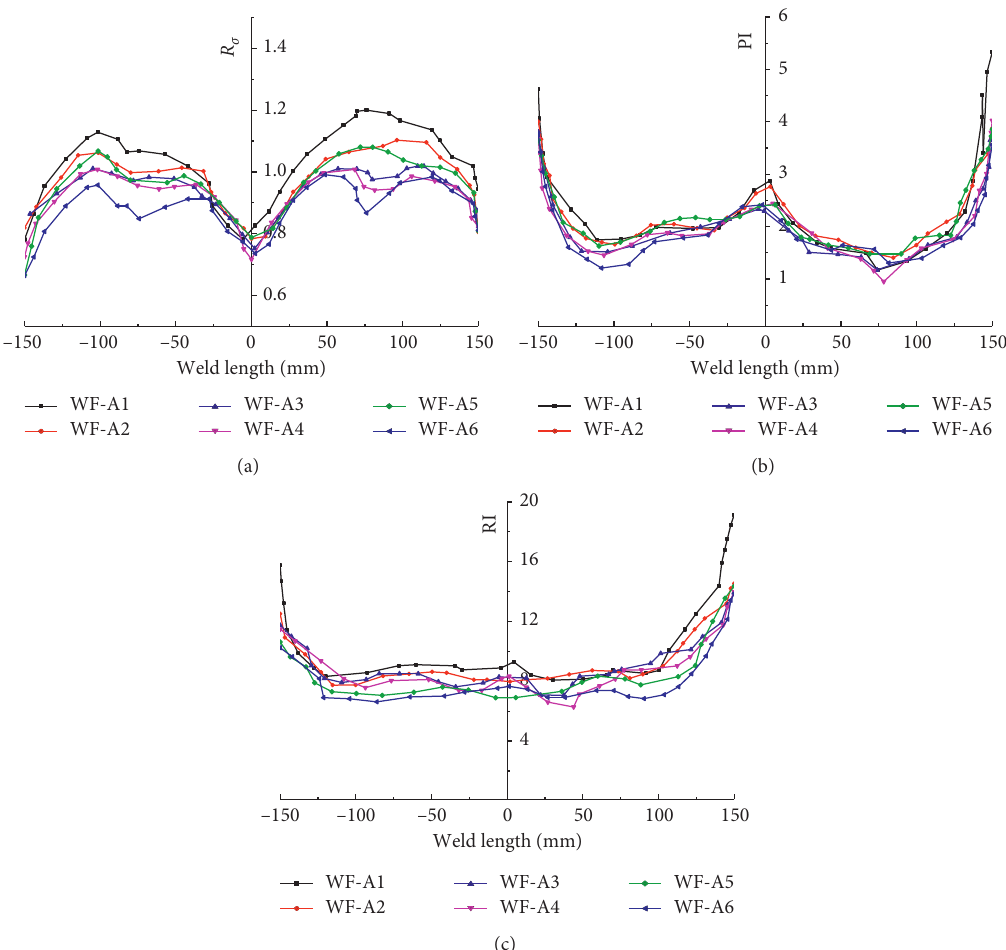
Figure 9: WF-A. (a) Triaxiality ratio. (b) Equivalent plastic strain index. (c) Cracking